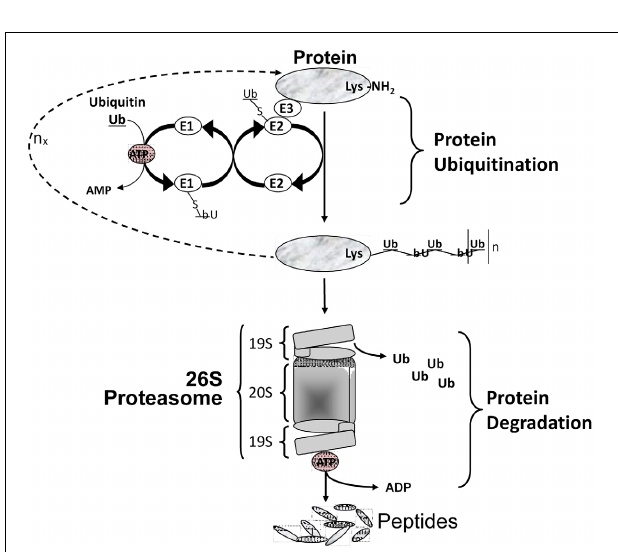
FIGURE 2 | Flow of genetic information and key steps in the regulation of gene expression. The level of protein expressed in the cell results from the net balance between protein synthesis and protein degradation. Protein synthesis can be regulated via several processes including those operating at the transcriptional, post-transcriptional, pre-translational, translational, and post-translational levels. The product of each step is subjected to degradation control.